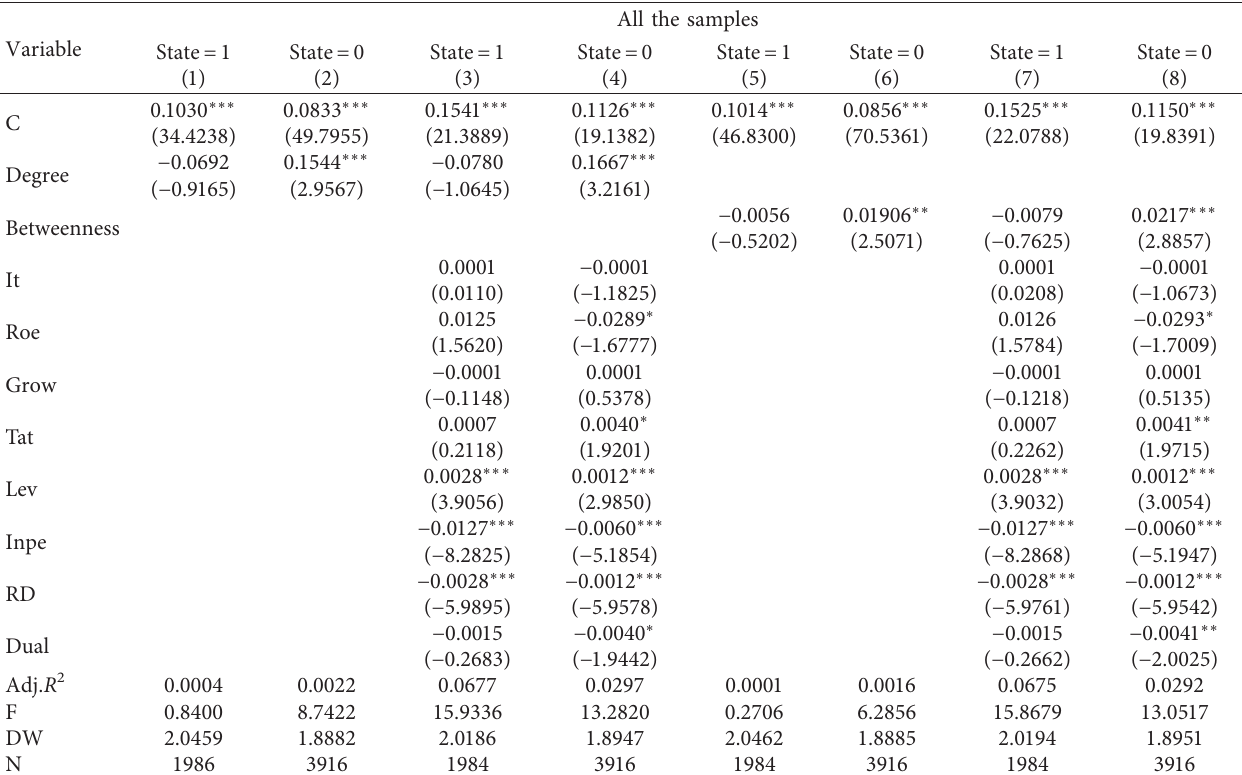
Table 5: Regression results: director networks, property right nature, and cost of equity capital.